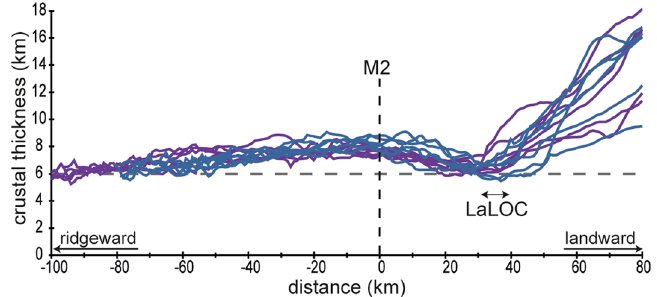
Figure 6. Crustal thickness variation with respect to the M2.o magnetic anomaly on both conjugated margins between Chui-Cape Cross FZ and 38°S on the South American plate and 31°S on the African plate for 6 profiles across the Namibian margin (in dark blue) and 7 profiles across the Uruguayan and Brazilian margins (in purple). Distances are increasing landward. The dashed horizontal grey line indicates 6 km crustal